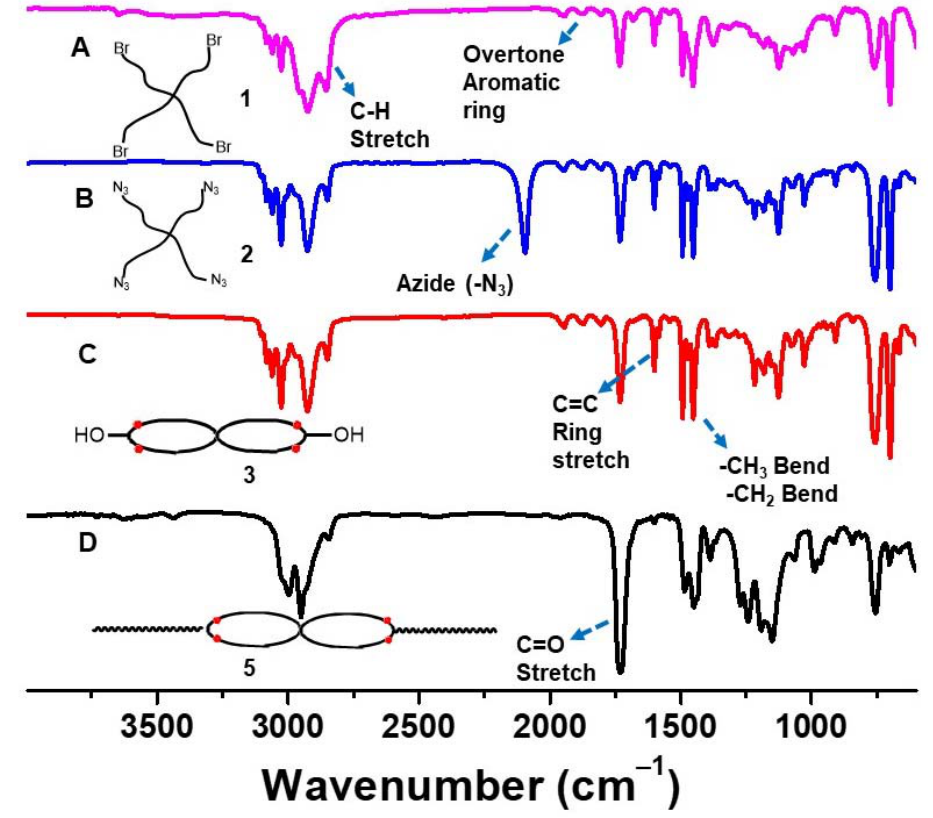
Figure 3. FT-IR spectra of ( A ) tetra-arm PS-Br, ( B ) tetra-arm PS-N 3 , ( C ) spirocyclic PS, and ( D ) PMMA- b -cPS- b -PMMA triblock copolymer.